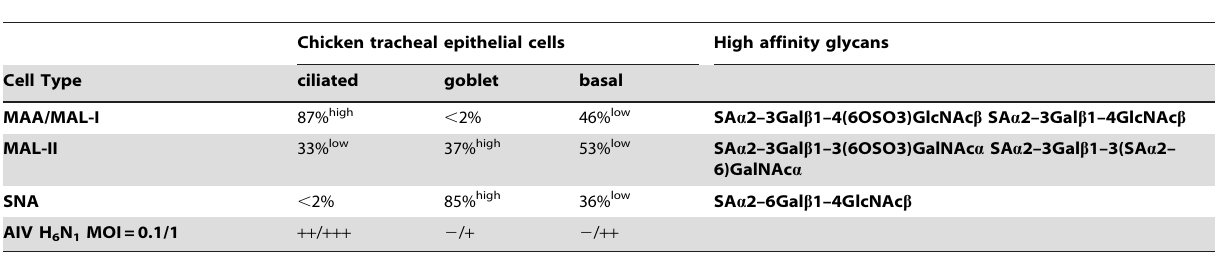
Table 1. The predominant glycans binding to the lectins and H6N1.